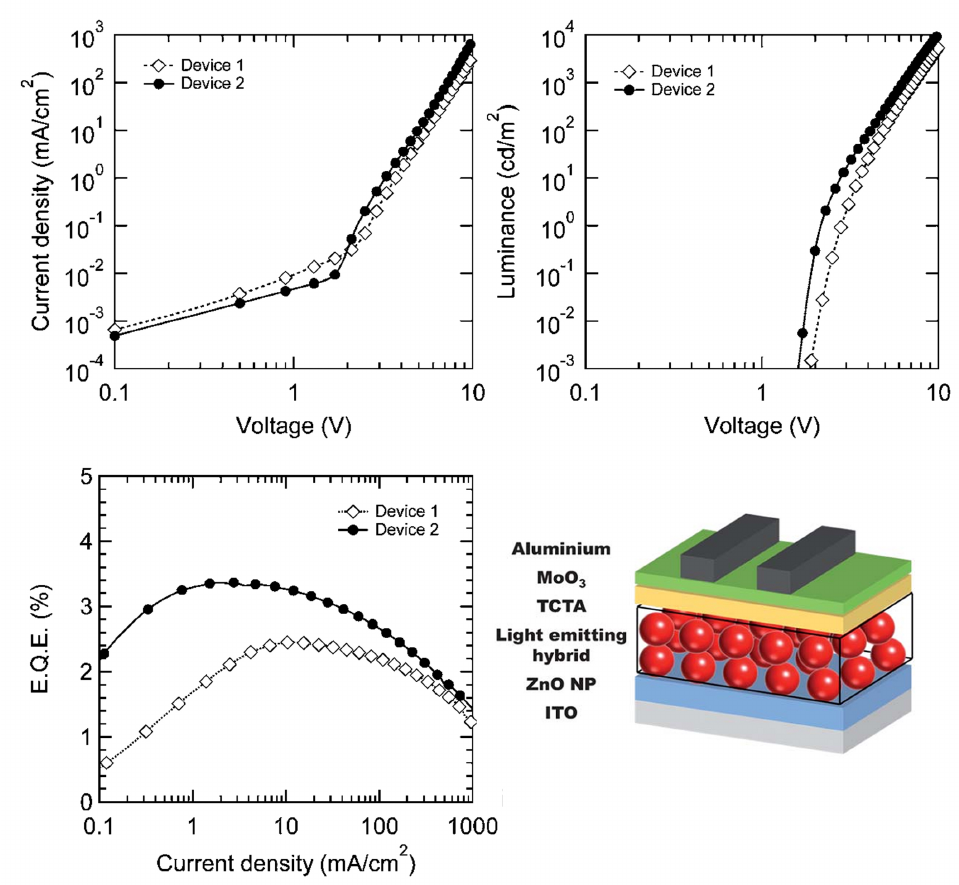
Figure 12. Voltage dependence of the current density ( top left ), luminance ( top right ) EQE ( bottom left ) and device structure of the light emitting diode (LED) realized in [94]. Adapted with permission from [94]. The Royal Society of Chemistry,